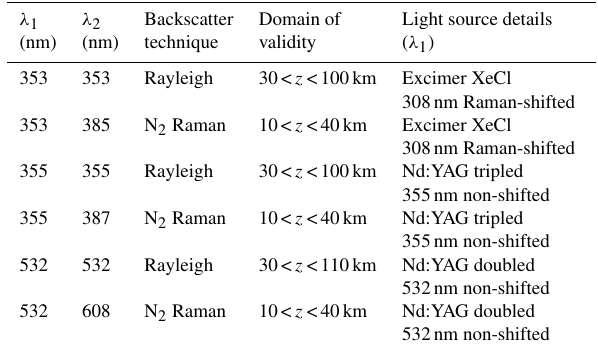
Table 1. List of most commonly used backscatter temperature lidar